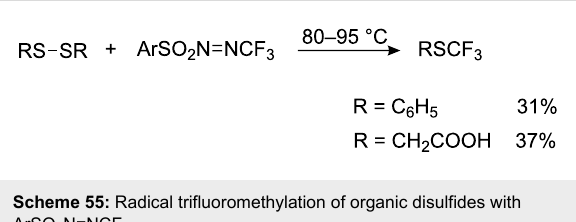
R t (h) Yield of ArSCF 3 (%)